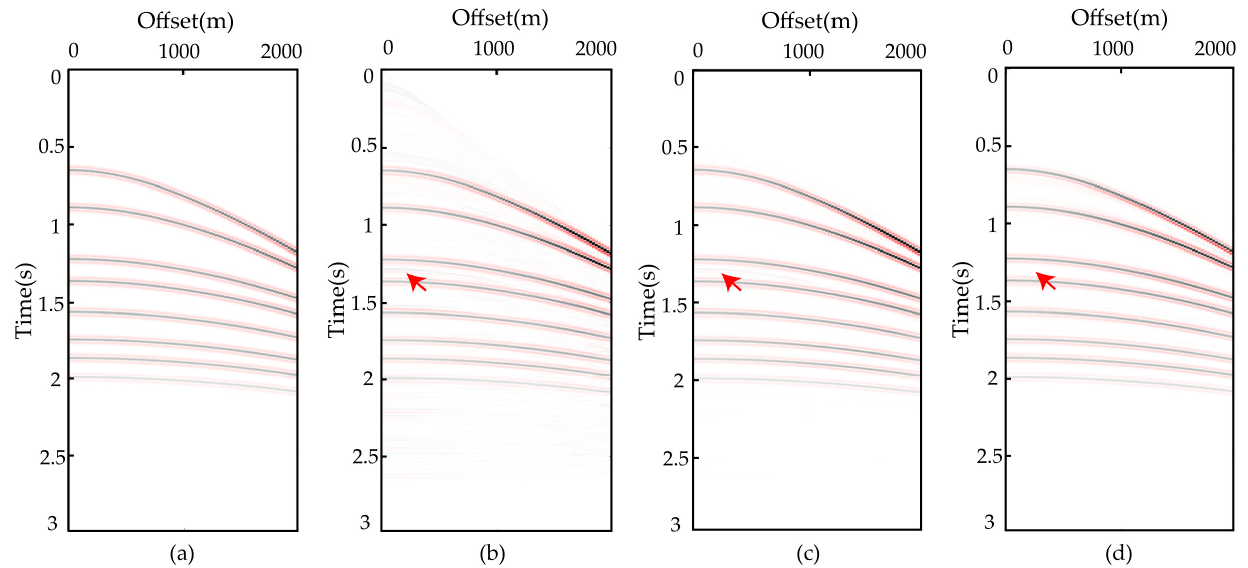
Figure 5. Multiple attenuation result of the theoretical model data: ( a ) without multiple wavefield data; ( b ) LSPRT method; ( c ) SPRT L 1 method; ( d ) SPRT L q 1 − L q 2 method. The red arrows indicate the multiples suppression effect of the three algorithms, and there is no residual multiples in Figure 5d.